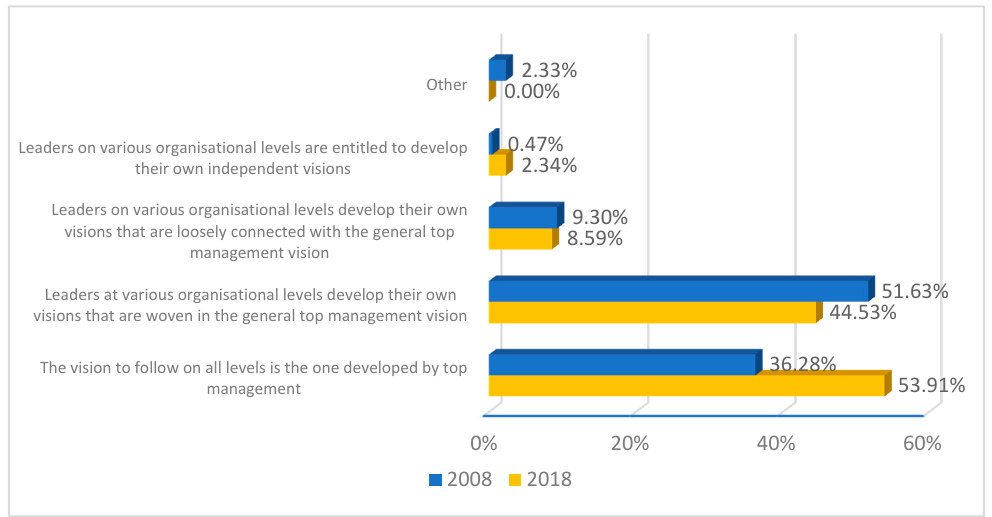
Figure 4. The vision development process as assessed by leaders of the Forbes Global 2000 world’s largest corporations.